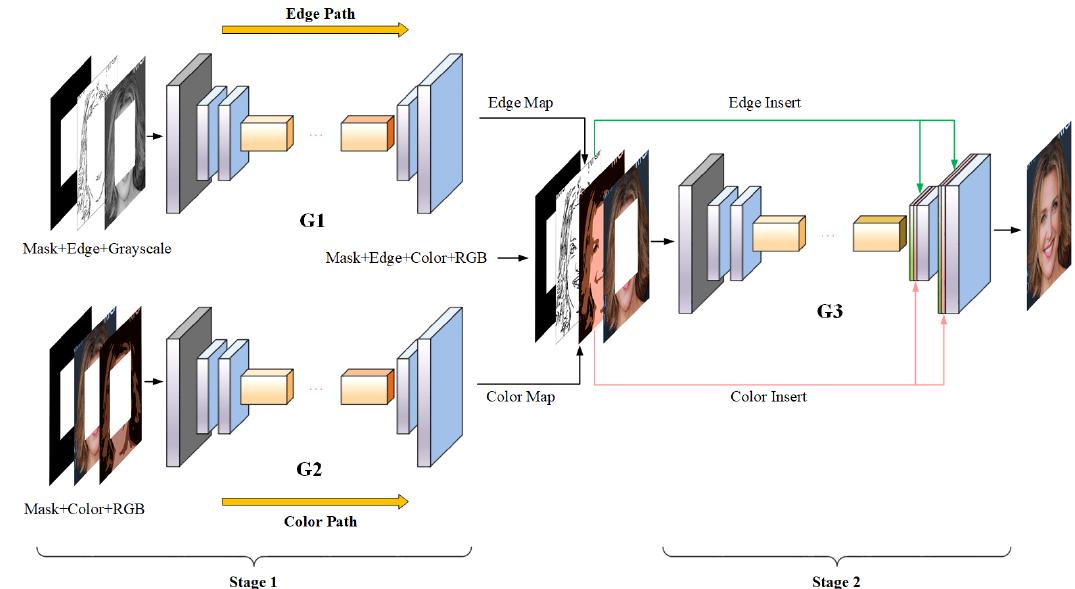
Figure 1. Overview of the PIC-EC (Parallel Image Completion with Edge and Color) framework for image completion. Masked edge map ˜ E gt , masked grayscale image ˜ I gray and the mask M are the inputs of G 1 to predict the full edge map E comp . Masked color map ˜ C gt , masked RGB image ˜ I gt and the mask M are the inputs of G 2 to generate the full color map C comp . Generated edge map, generated color map and masked RGB image are then concatenated with the mask, and fed to G 3 to get the completed image I comp